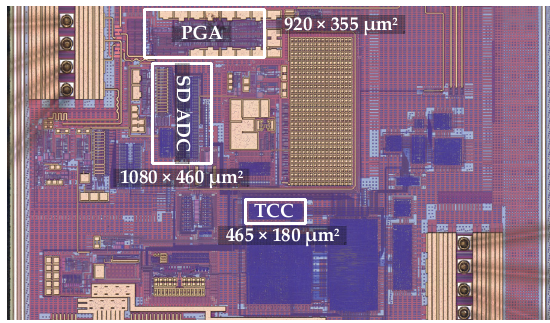
Figure 9. Chip microphotograph. Figure 9. Chip Table 2. TCC performance summary.